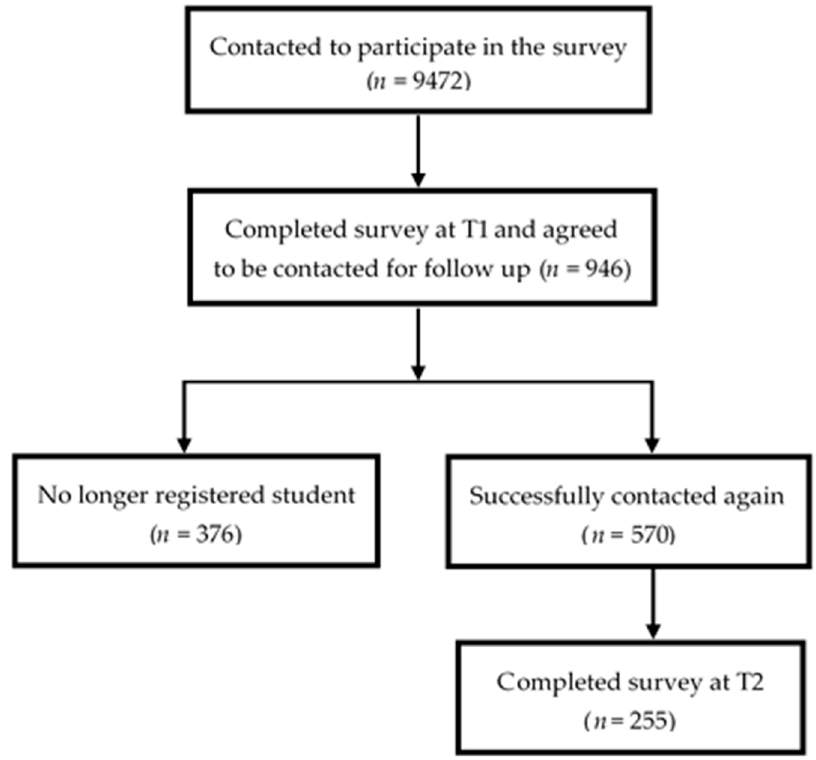
Figure 1. Flow chart displaying the participant recruitment process for the